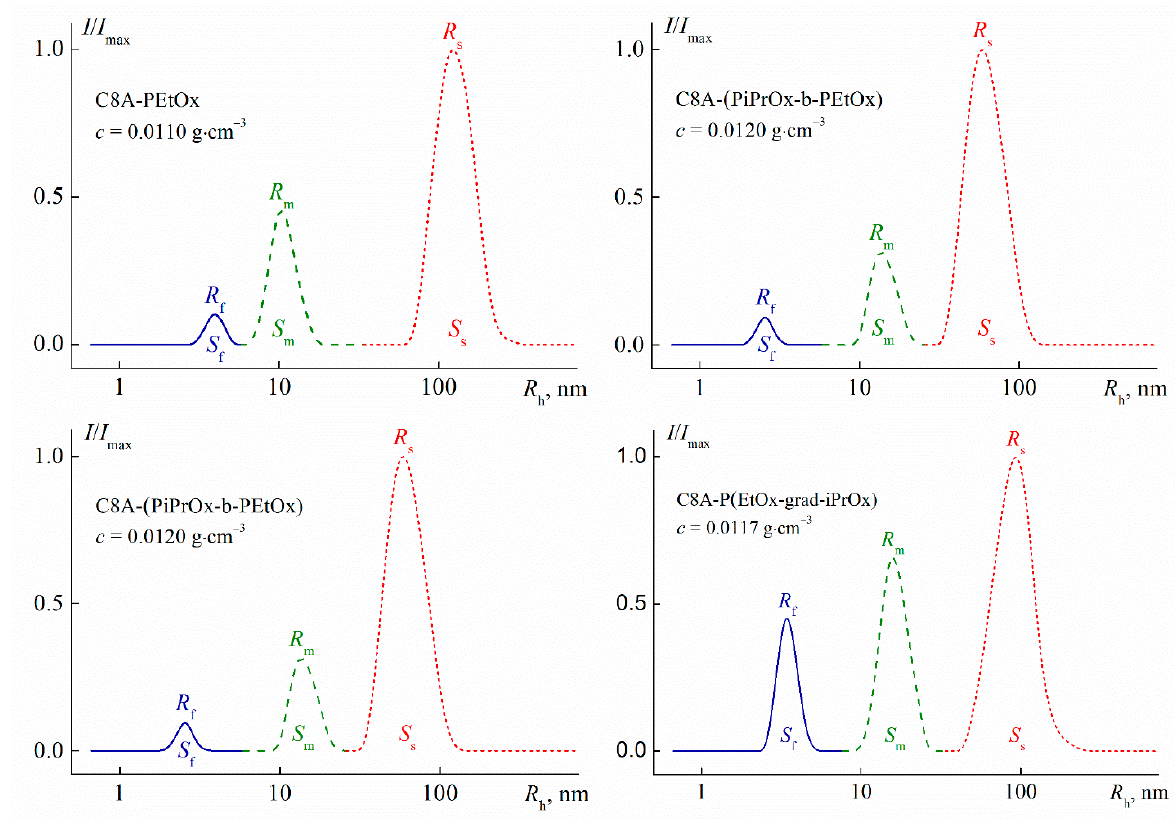
Figure 7. The dependences of relative intensity I / I max of scattered light on the hydrodynamic radius R h of scattering species for aqueous solutions of C8A-PAlOx at 21 °C. I max is the maximum value of light scattering intensity for the given solution concentration.